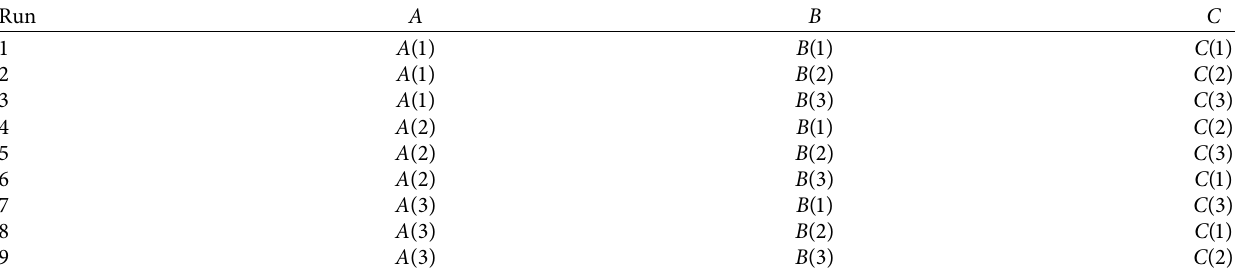
Table 6: Taguchi’s orthogonal arrays matrix (SA).